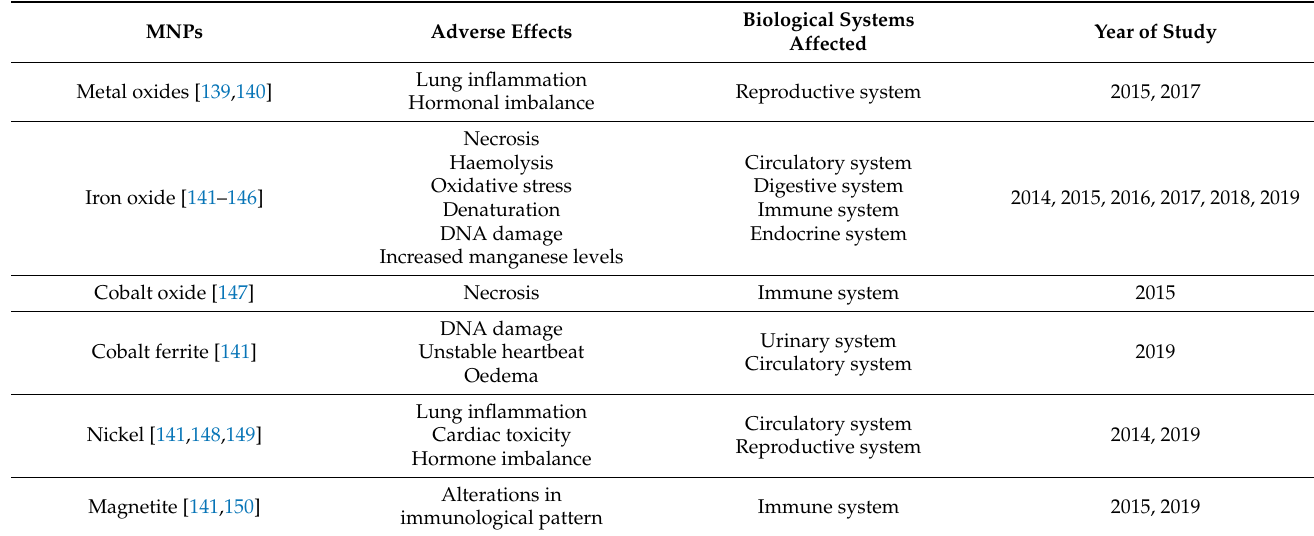
Table 4. Some of the toxic effects of several MNPs and their impact on the body.